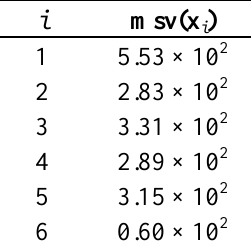
from the desired swing motion. i